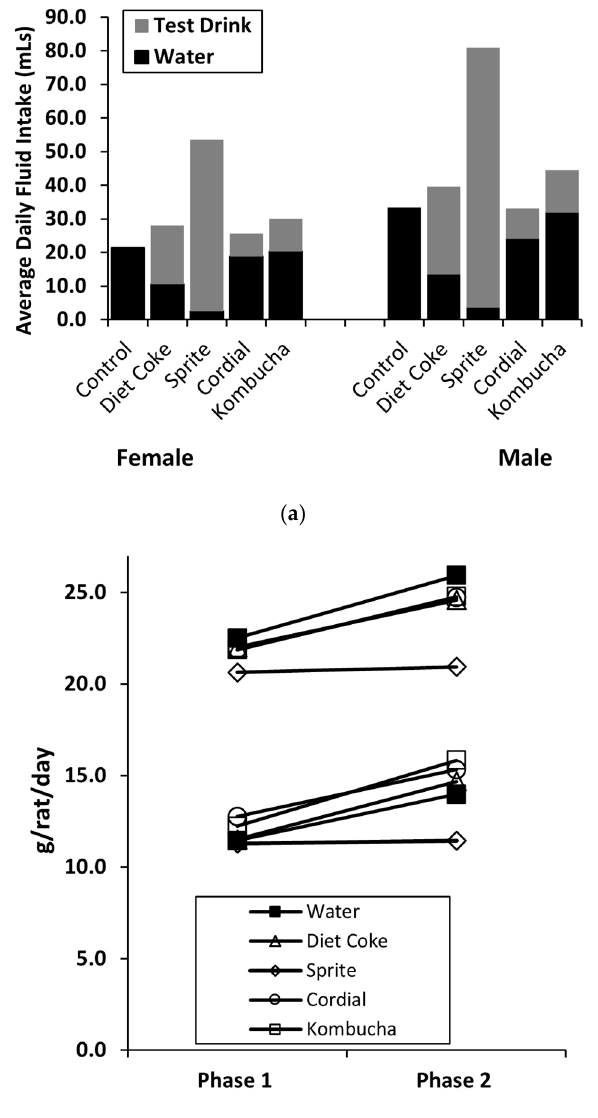
Figure 5. Phase 2 consumption data for the mean total daily fluid intake in Phase 2 ( a ) and chow intake ( b ). Sprite was highly consumed during 28 days of NNS exposure, followed by Diet Coke, Kombucha, and Cordial. Chow consumption increased for all the groups except Sprite, where it remained unchanged ( n = 8/group).